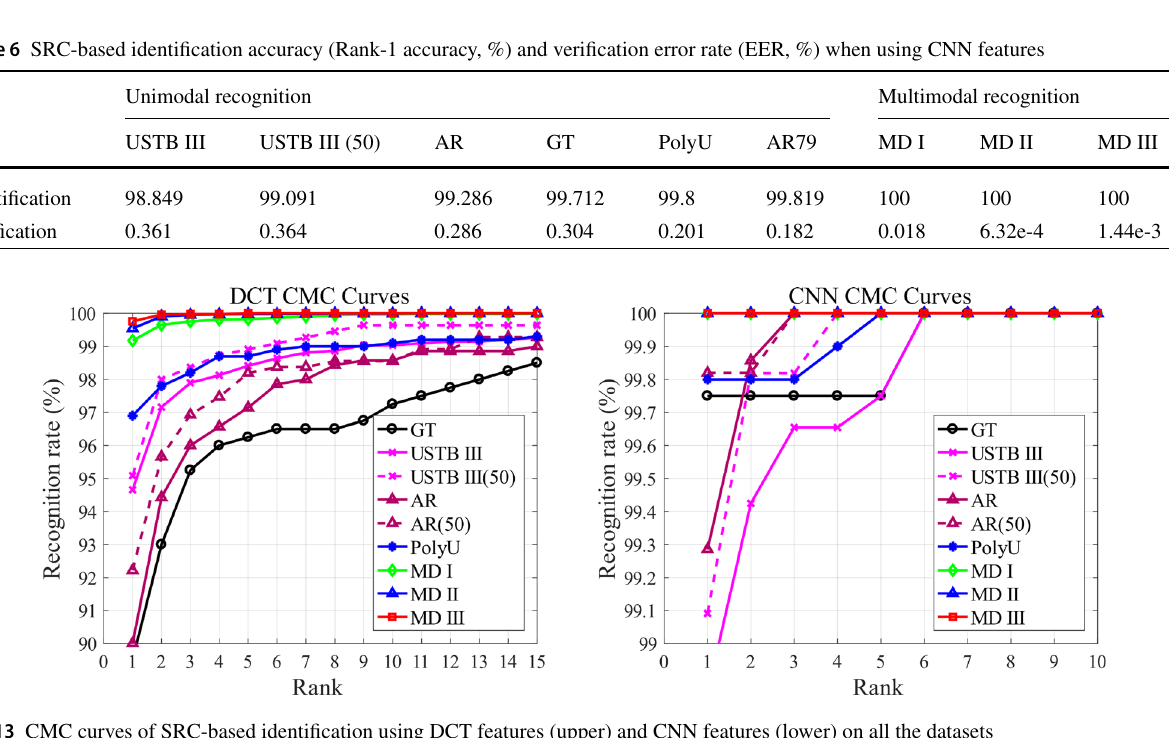
0% FRR very soon and they even lay on the axes when using CNN features, as shown in Figs. 11 and